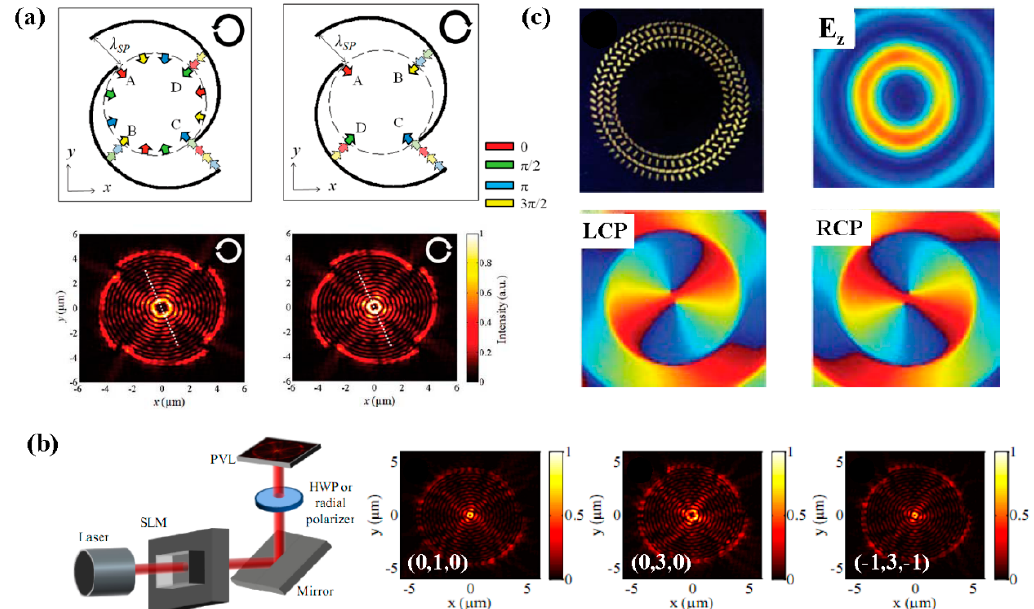
Figure 5. For Archimedes spiral slits, the topological charge of SPP vortex can be modulated by the polarization ( a ) or topological charge ( b ) of the incident light [21,44]. ( c ) For SPP vortex generator